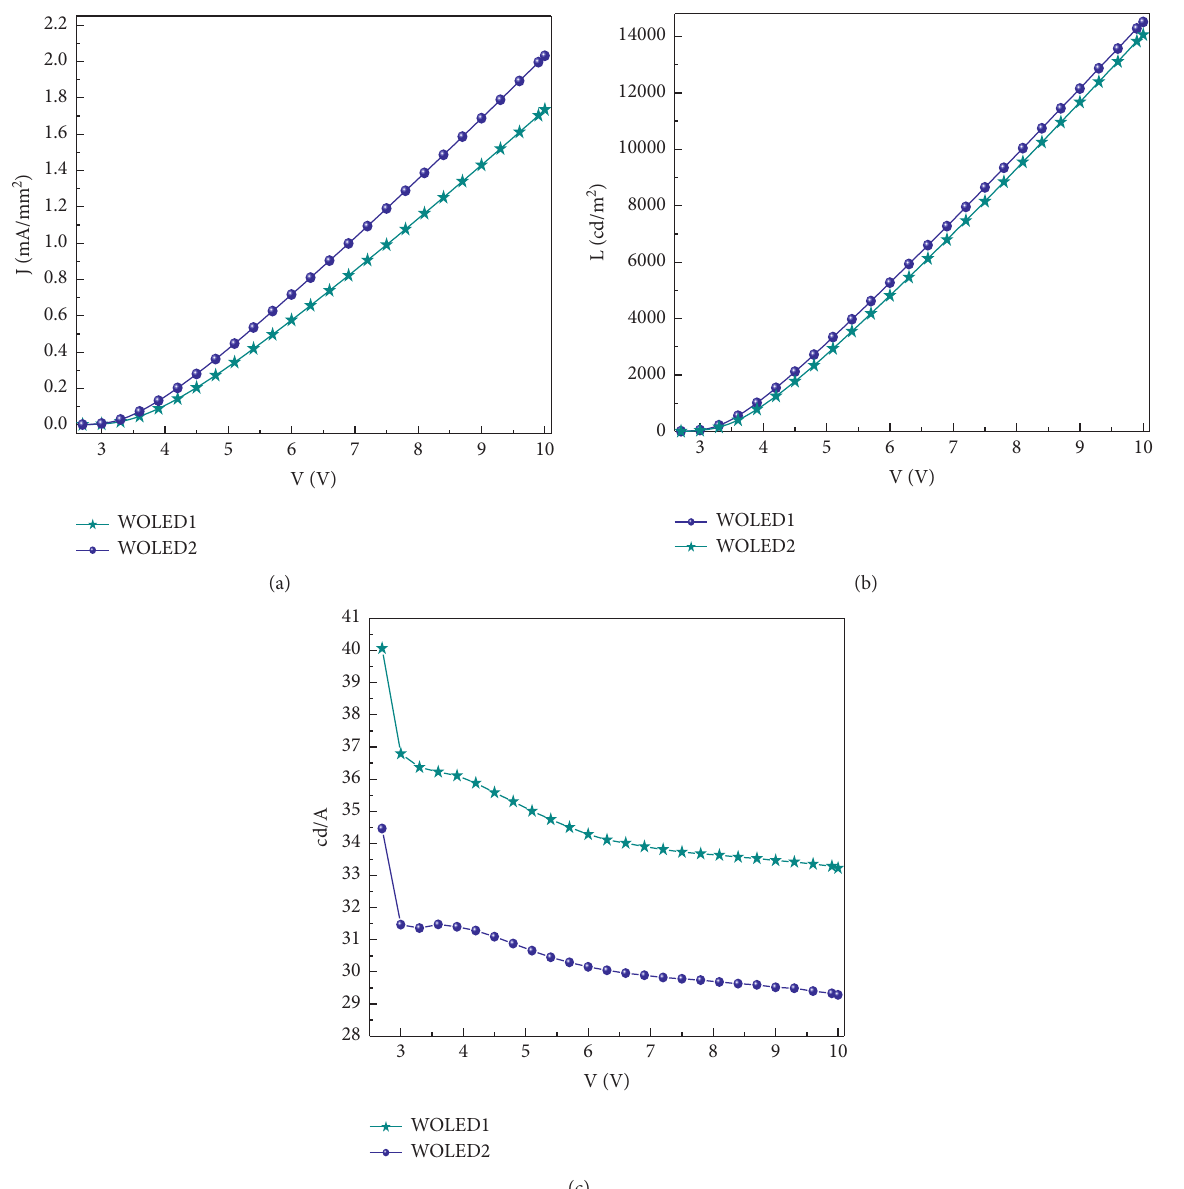
Figure 5: (a) J-V characteristic curves of white OLED, (b) L-V characteristic curves of white OLED, and (c) light-emitting efficiency of white